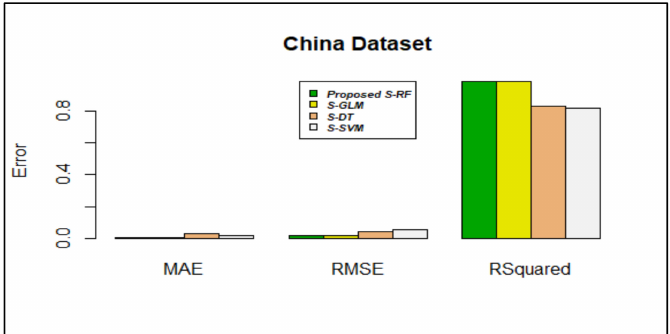
Figure 4. Error rate vs. stacking models in the China dataset.